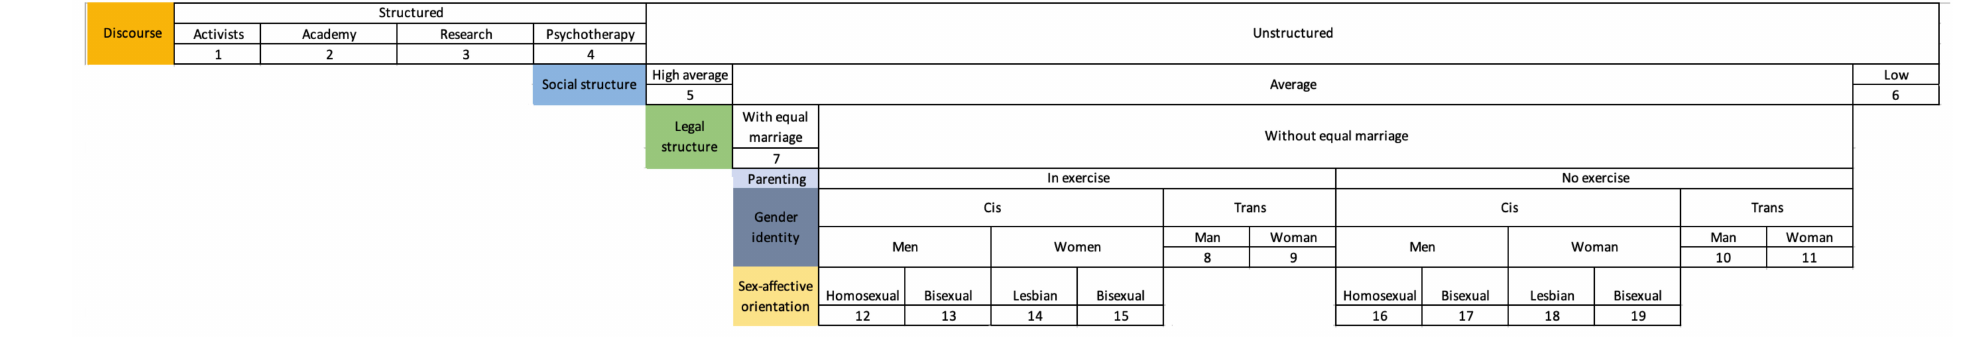
Figure 1. Sociostructural